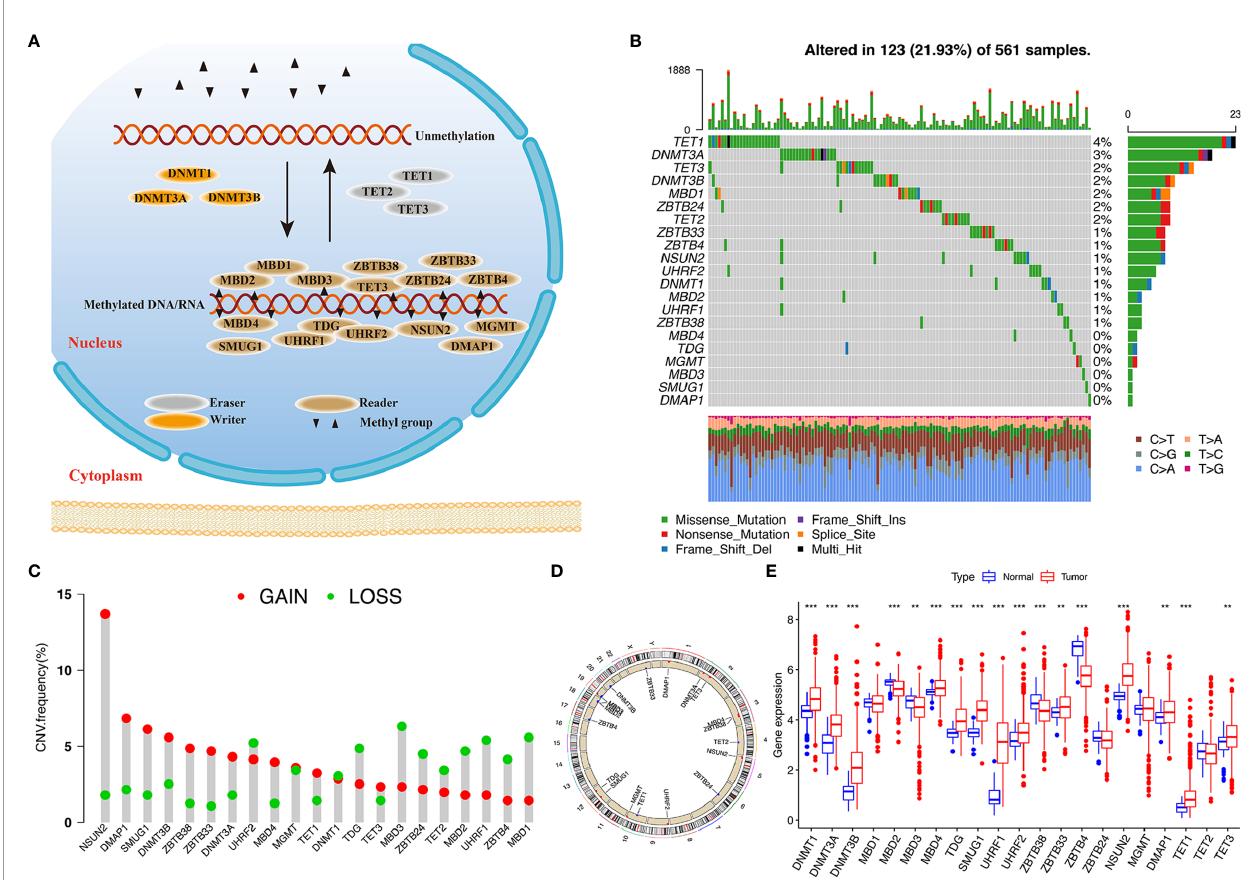
FIGURE 1 | Landscape of genetic variation of DNA methylation regulators in LUAD. (A) Summary of 21 DNA methylation regulators and their potential biological processes. (B) Mutation landscape of 21 DNA methylation regulators in 561 LUAD patients. Individual patients are presented in the upper column. Mutation frequency of each regulator are represented in the right bar plot. (C) The CNV frequency of 21 DNA methylation regulators in TCGA cohort. (D) The location of 21 regulators on chromosomes. (E) Differences in gene expression levels of 21 regulators between normal and tumor patients in TCGA cohort. ** p < 0.01, *** p <